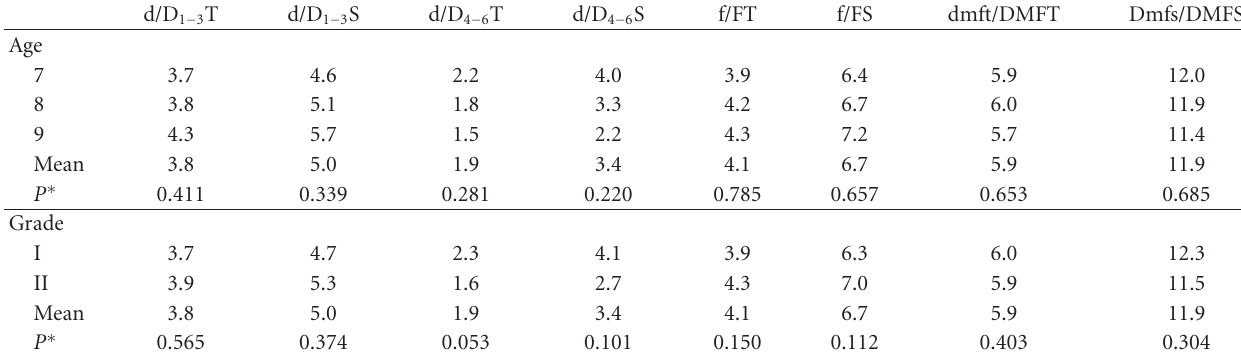
Table 4: The caries indices by age and